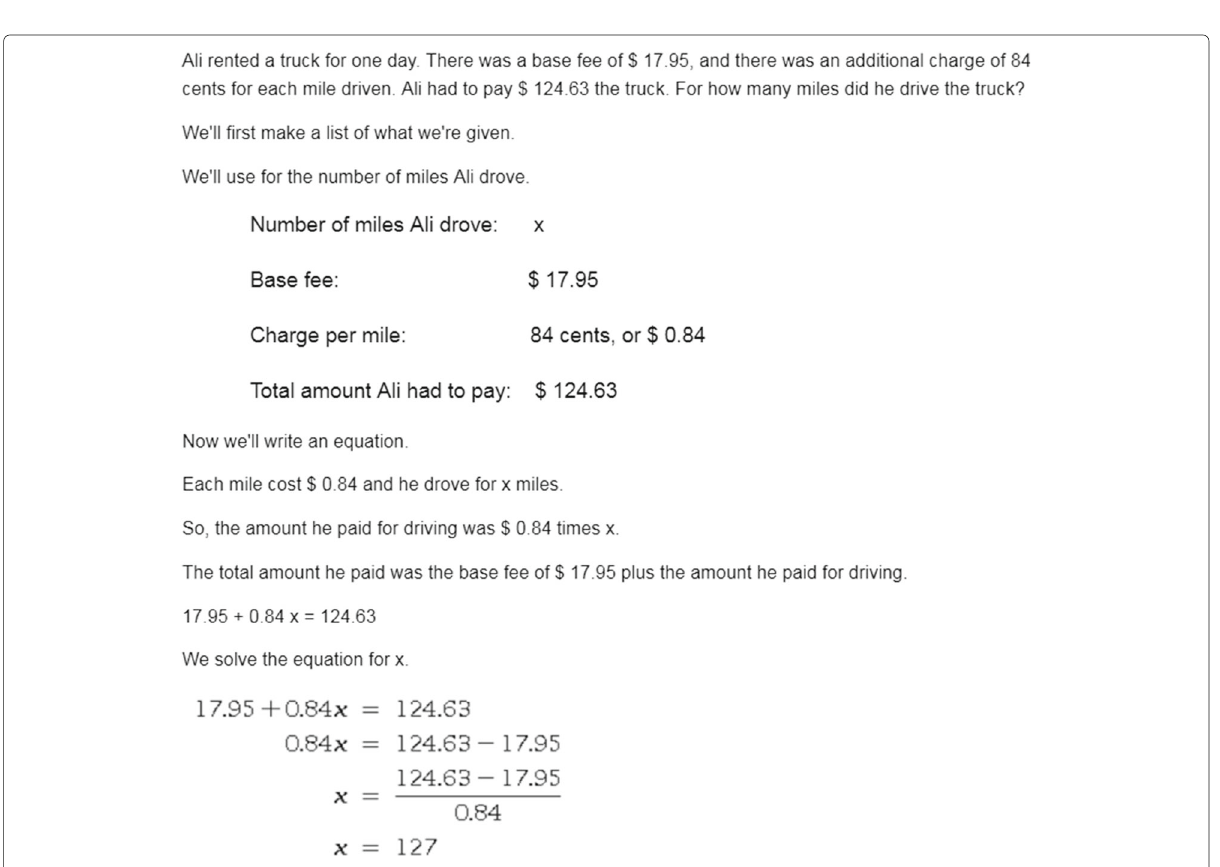
Fig. 7 Full-worked example for tutored example shown in Fig.